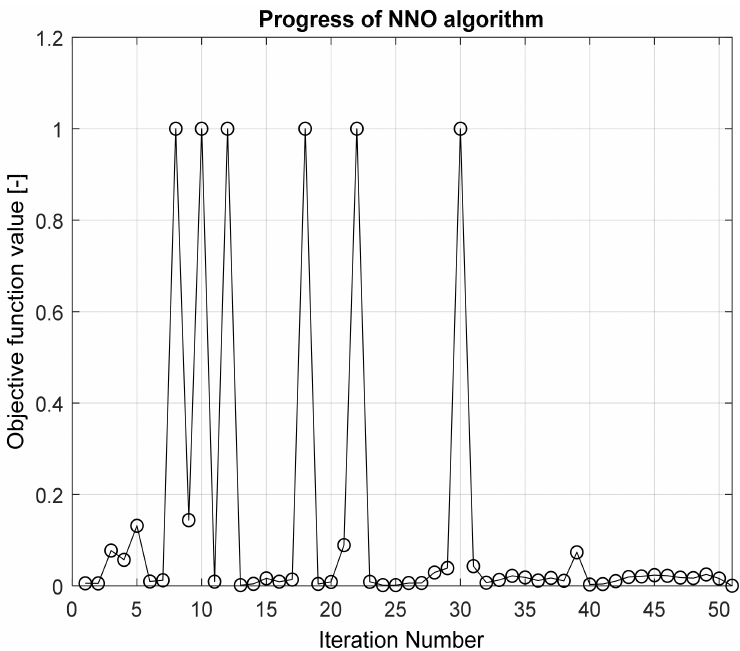
Figure 4. Evolution of the objective function during the NNO process.